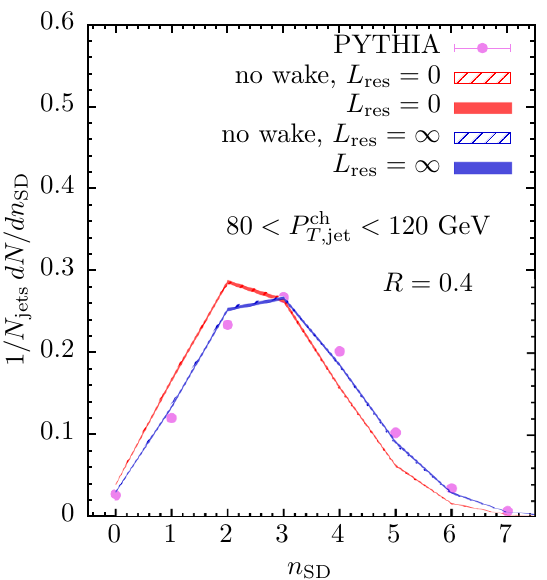
Figure 2 . Distribution of the number of Soft Drop splittings, n SD , in our hybrid model calculations with L res = 0 (red bands) and L res = 1 (blue bands) for 0{10% central heavy ion collisions with p s = 2 : 76 ATeV. We compare these results to the n SD distribution for jets in proton-proton collisions that shower in vacuum, obtained from PYTHIA and shown as the purple dots. The Soft Drop procedure used in the calculation is speci(cid:12)ed by the grooming parameters in the Soft Drop condition (4.1), chosen as z cut = 0 : 1 and (cid:12) = 0. The red and blue dashed bands (which are almost identical to the red and blue solid bands) show the results that we obtain upon ignoring particles originating from the moving wake deposited by the jet in the plasma; since these particles are soft, they hardly contribute to a groomed observable like n SD